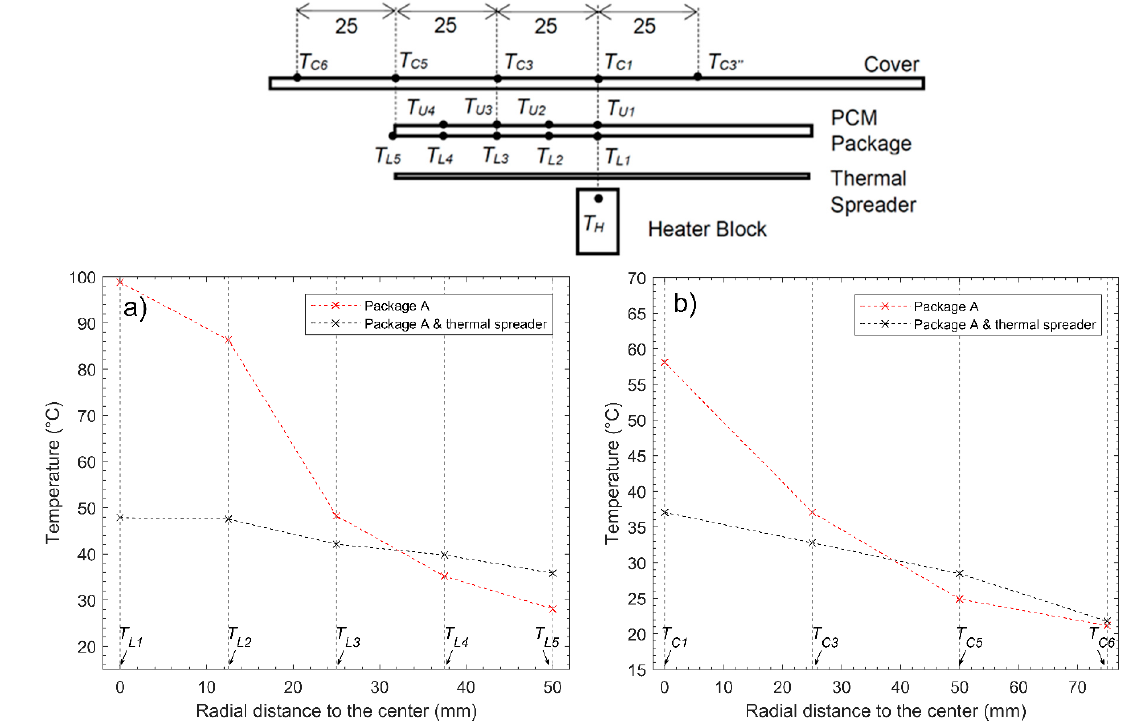
Figure 12. ( a ) Temperature of the lower surface ( T L 1 – T L 5 ) after 60 min of charging vs. the radial distance to the center; ( b ) temperature of the cover ( T C ) after 60 min of charging vs. the radial distance to the center for the experiment with PCM package A ( n -eicosane) with a spreader and without spreader.